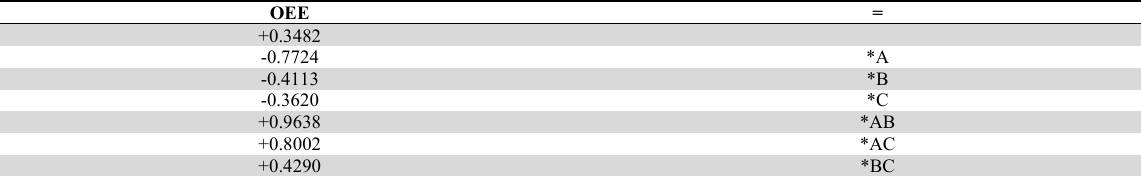
Final Equation in Terms of Coded Factors